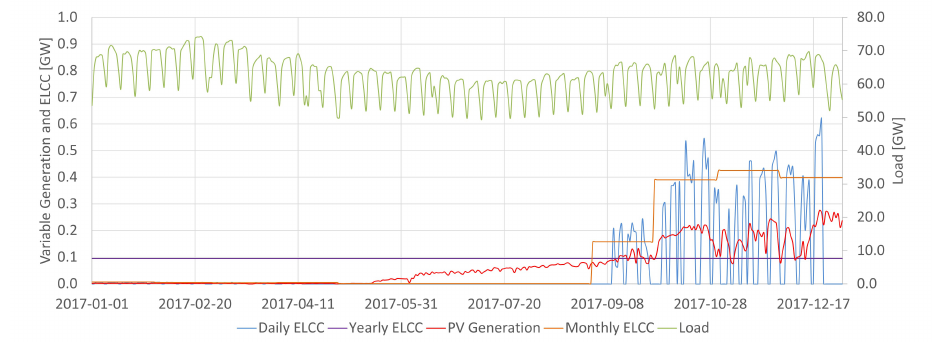
Figure 7. Daily, monthly and yearly ELCC for PV power in 2017 for the SIN.